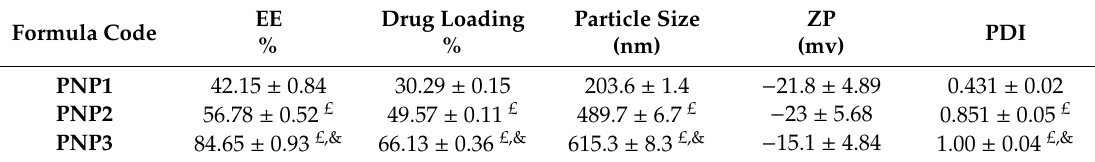
Table 2. The encapsulation e ffi ciency, drug loading capacity, particle size, zeta potential and polydispersity index of prepared